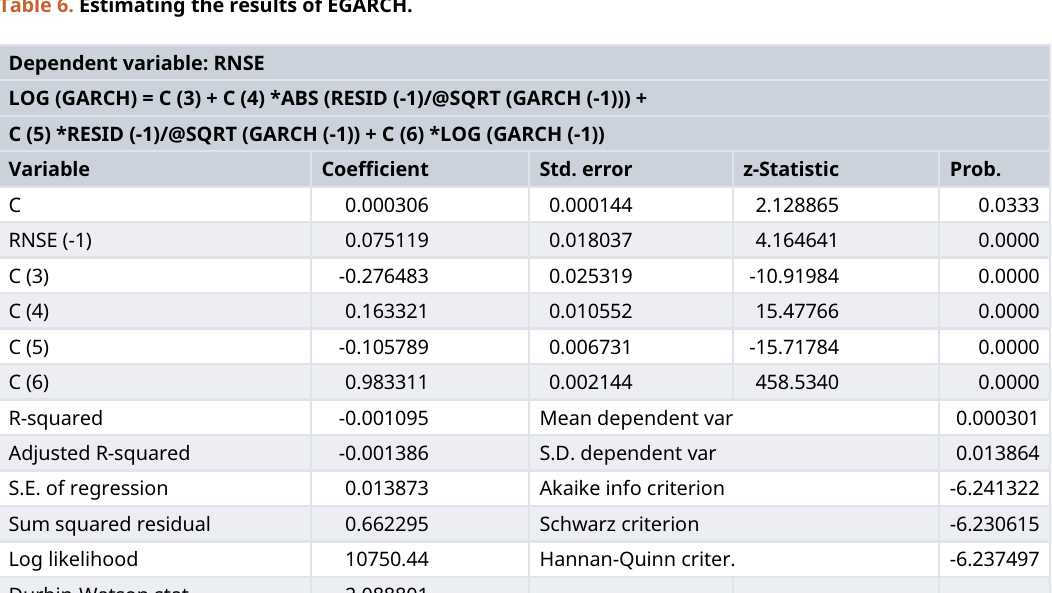
Table 6. Estimating the results of